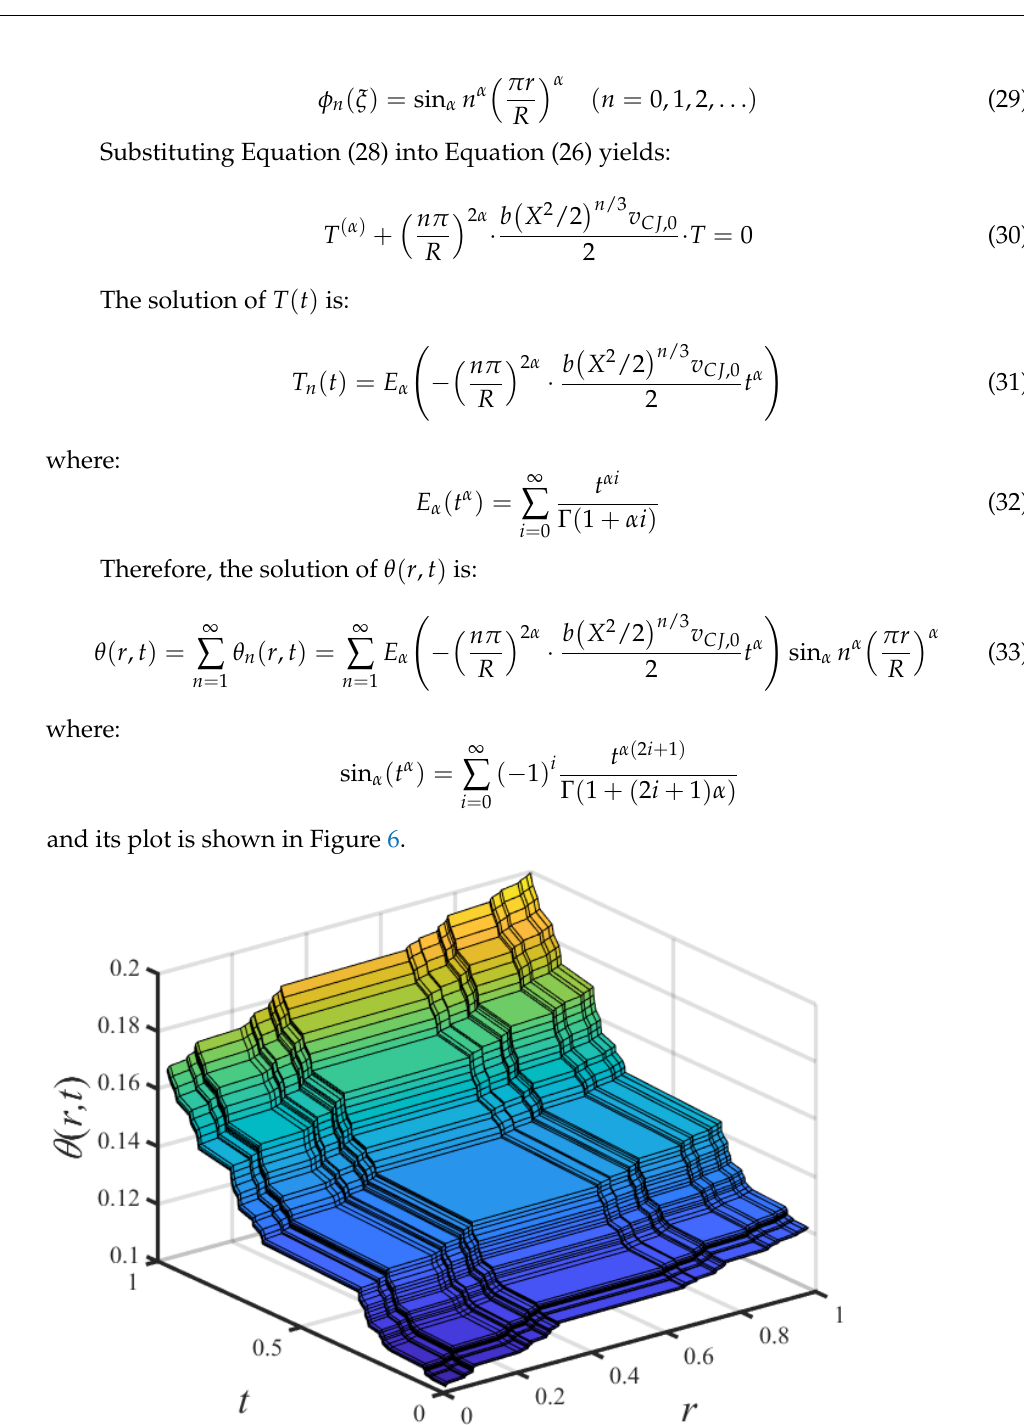
Figure 6. Nondifferentiable solution of local rotation angle with nondifferentiable sink term for α = ln2/ ln 3